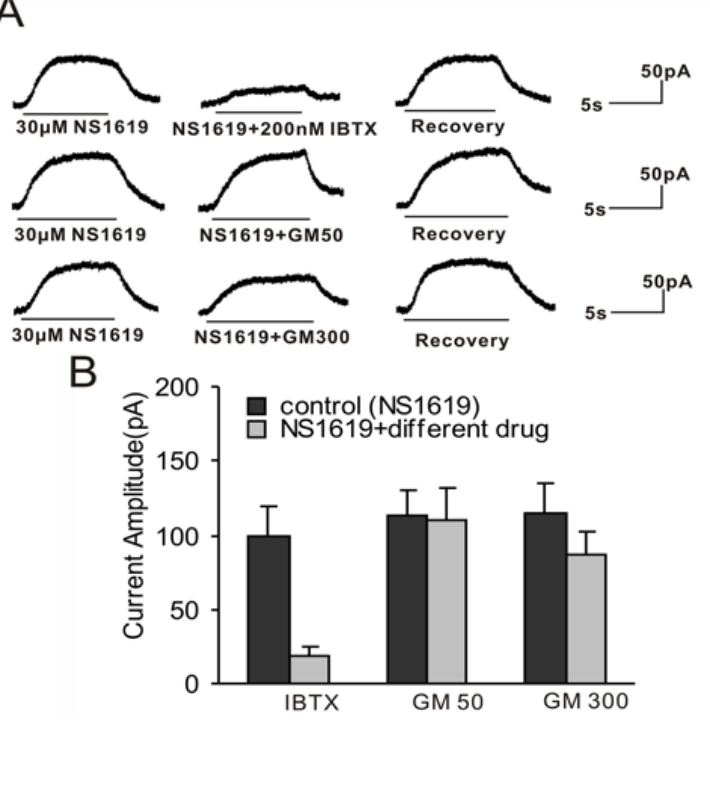
Figure 8. Effect of GM on NS1619-activated current (HP = −50 mV). ( A ) The NS1619-activated current was strongly blocked by 200 nM IBTX. In addition, 50 µM